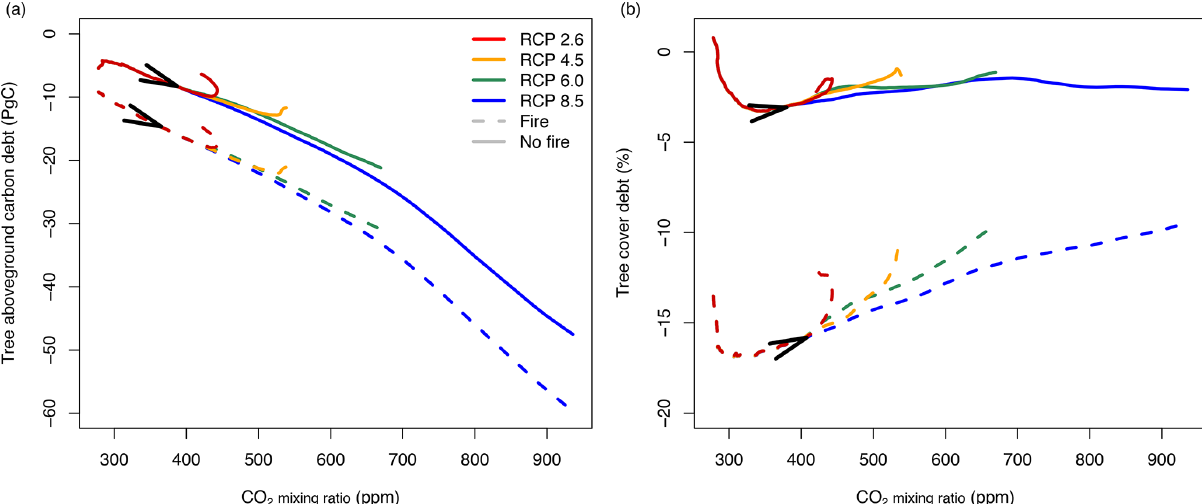
Figure 9. Vegetation carbon and tree cover debt when the atmospheric CO 2 mixing ratio increases according to different RCP scenarios. Lines represent differences between transient and equilibrium simulations averaged for all study sites in Africa (simulated at 2 ◦ resolution). Solid lines represent simulations without fire, and dashed lines represent simulations with fire. Arrows indicate time between 1950 and